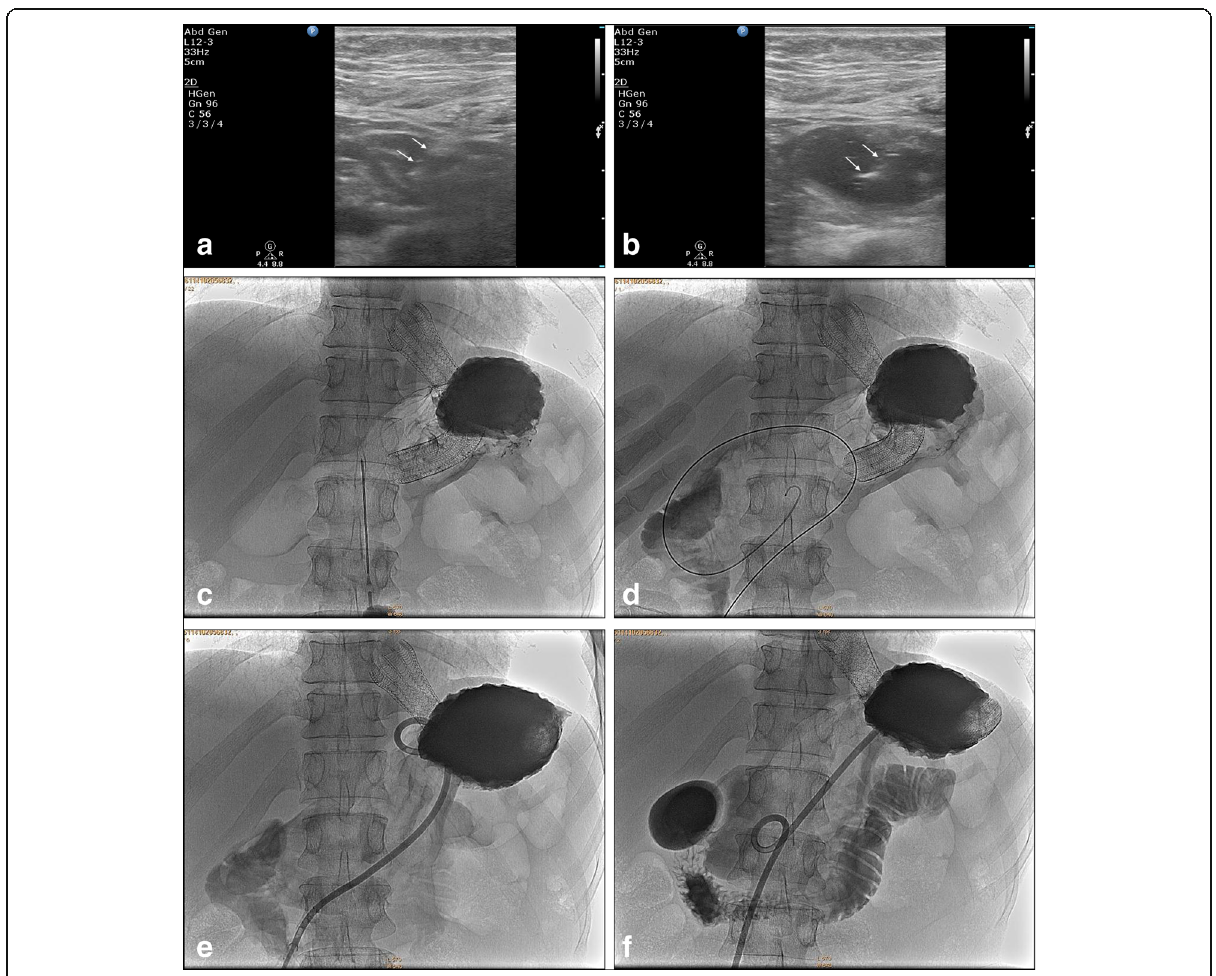
Fig. 2 A 45-year-old male patient with cancer esophagus and migrated non-functioning stent. a Ultrasound-guided gastric access by 18-G needle (arrows) in the antrum away from the migrated stent. b Distension of the stomach by diluted non-ionic contrast medium. c Fluoroscopic